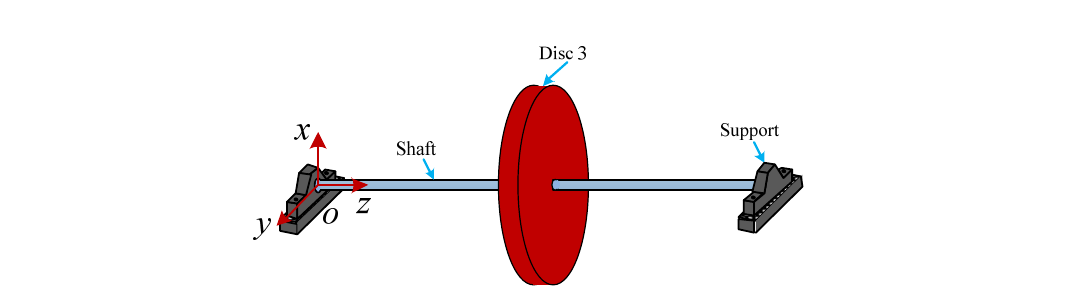
Figure 2. Schematic diagram of an integrated rotor system.